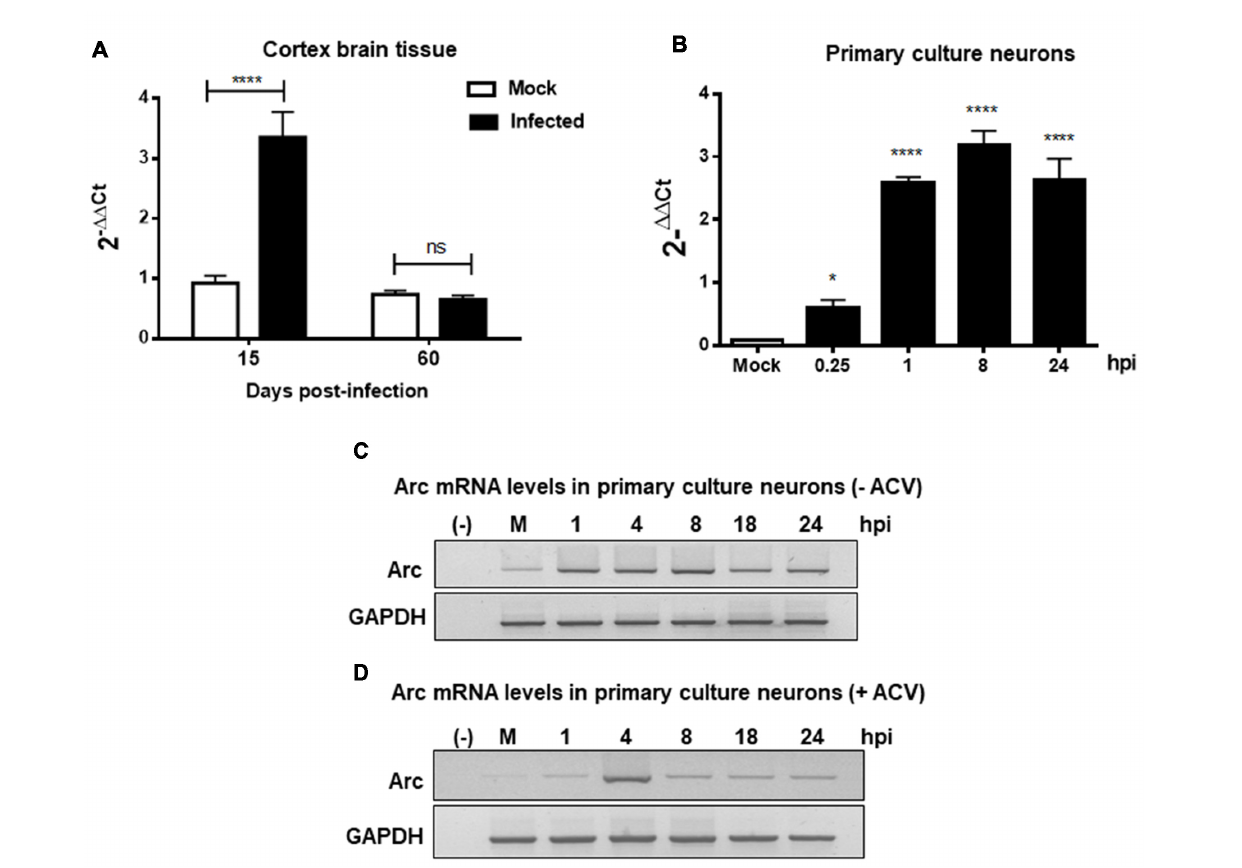
FIGURE 3 | HSV-1 neuronal infection and replication triggers upregulation of Arc mRNA levels. Arc mRNA levels were analyzed by RT-qPCR in either (A) Brain cortex of mock and HSV-1 infected mice at 15 or 60 dpi or (B) mouse primary culture neurons infected during 24 h with HSV-1 and mock conditions. Relative Arc mRNA expression levels were controlled in respect to the levels of the housekeeping gene PPIA. After gel scanning and densitometry quantitation, the results were expressed as the ratio of Arc mRNA in respect to PPIA mRNA levels. Experiments were performed in triplicate. ∗∗∗∗ p > 0.0001 and ∗ p > 0.05; ns: non-significant (using Two-Way ANOVA analyze in graphic A , and One-Way ANOVA analyze in graphic B ). Conventional RT-PCR in Mock- and HSV-1-infected (MOI = 10) mouse primary culture neurons during 1, 4, 8, 18 and 24 hpi without (C) or with (D) acyclovir (ACV) treatment added during the time course of infection.